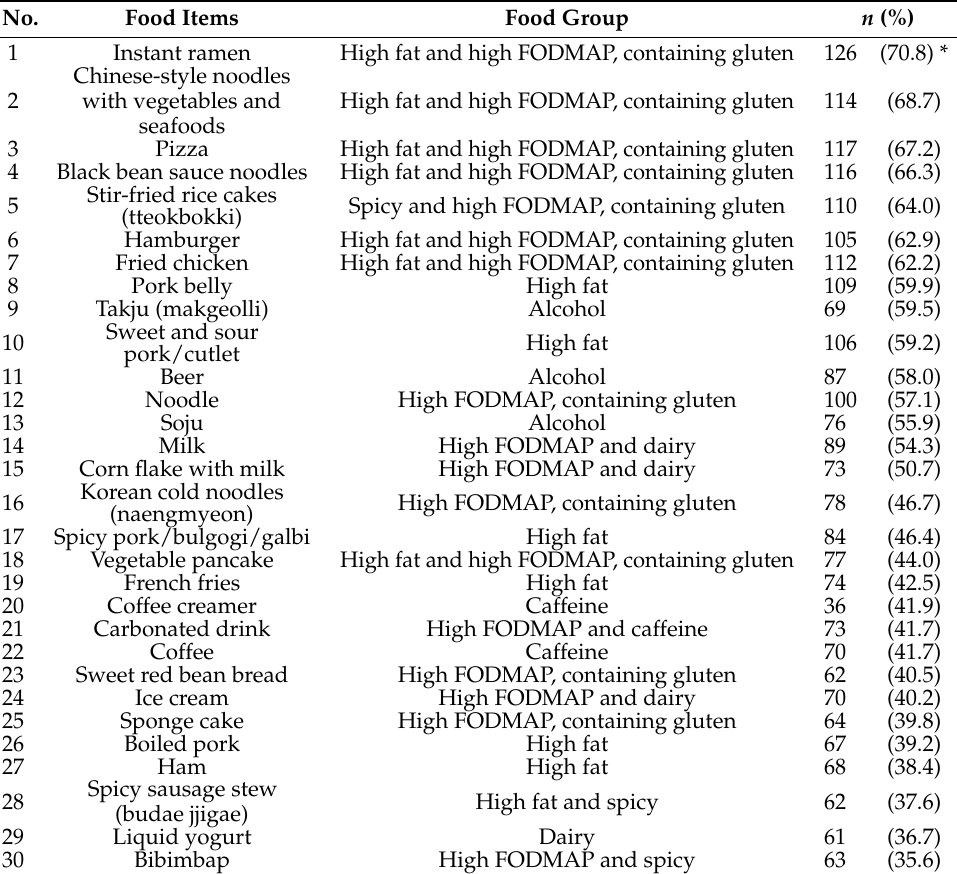
Table 3. Top 30 food items causing symptoms in IBS patients.